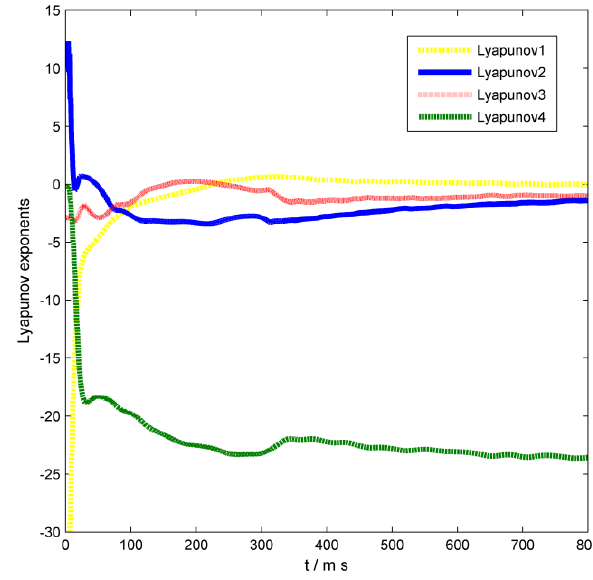
Figure 6. Lyapunov exponents of the time-delay system.